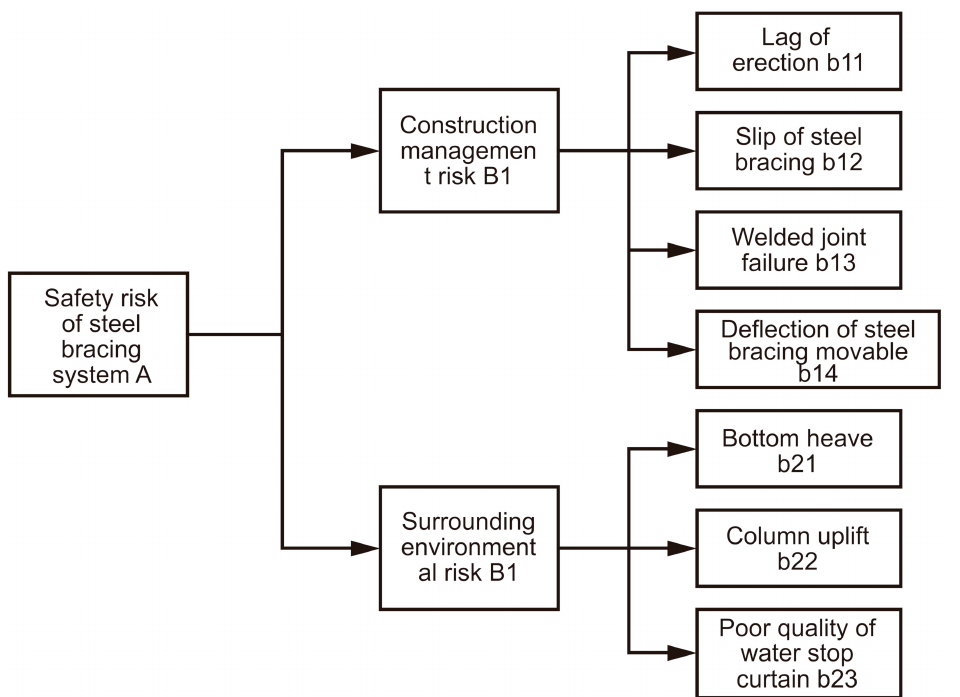
After rough and intensive reduction, the impact of b 11 and b 23 among the original factor indicators was small and could be ignored and removed. The risk indicators were redefined as shown in Figure 8.